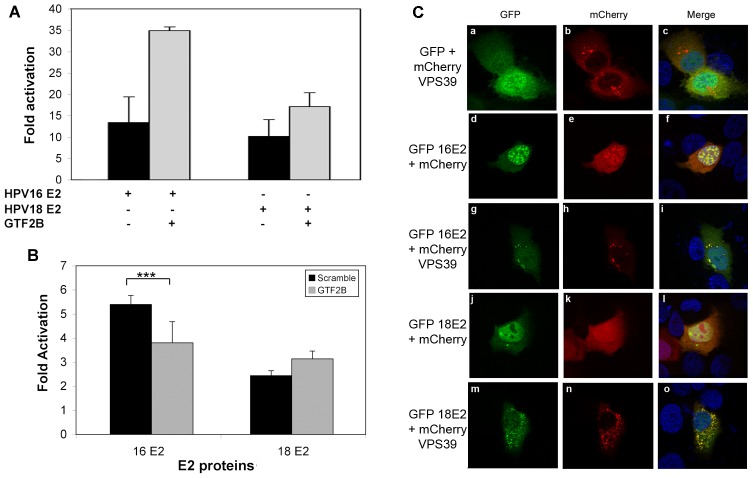
Validation of HR-specific interactions.(A) HeLa cells were transfected by pTK6E2BS-Luc reporter and HPV16 or HPV18 E2 expression plasmids. Where indicated, GTF2B was added. Fold activation is given relative to TK6E2BS-Luc in the absence of E2. (B) HeLa cells were transfected with a pool of four siRNA targeting GTF2B or control siRNA (Scramble). 48 h post silencing, pTK6E2BS reporter plasmid was transfected along with E2 expression plasmids. Results are given as a fold activation relative to TK6E2BS basal activity in the presence of the same siRNA. Experiments were performed in triplicate with each bar representing the mean ± SD. The stars (***) indicate a statistical significant difference between fold activation by 16E2 with a scramble siRNA or a GTF2B-directed siRNA directed (p-value<0,001) (C) HaCaT cells were co-transfected by GFP-E2 proteins from HPV16 or HPV18 and mCherry-VPS39. 24 h later, cells were fixed in 4% paraformaldehyde, stained with DAPI and subjected to fluorescence microscopy.